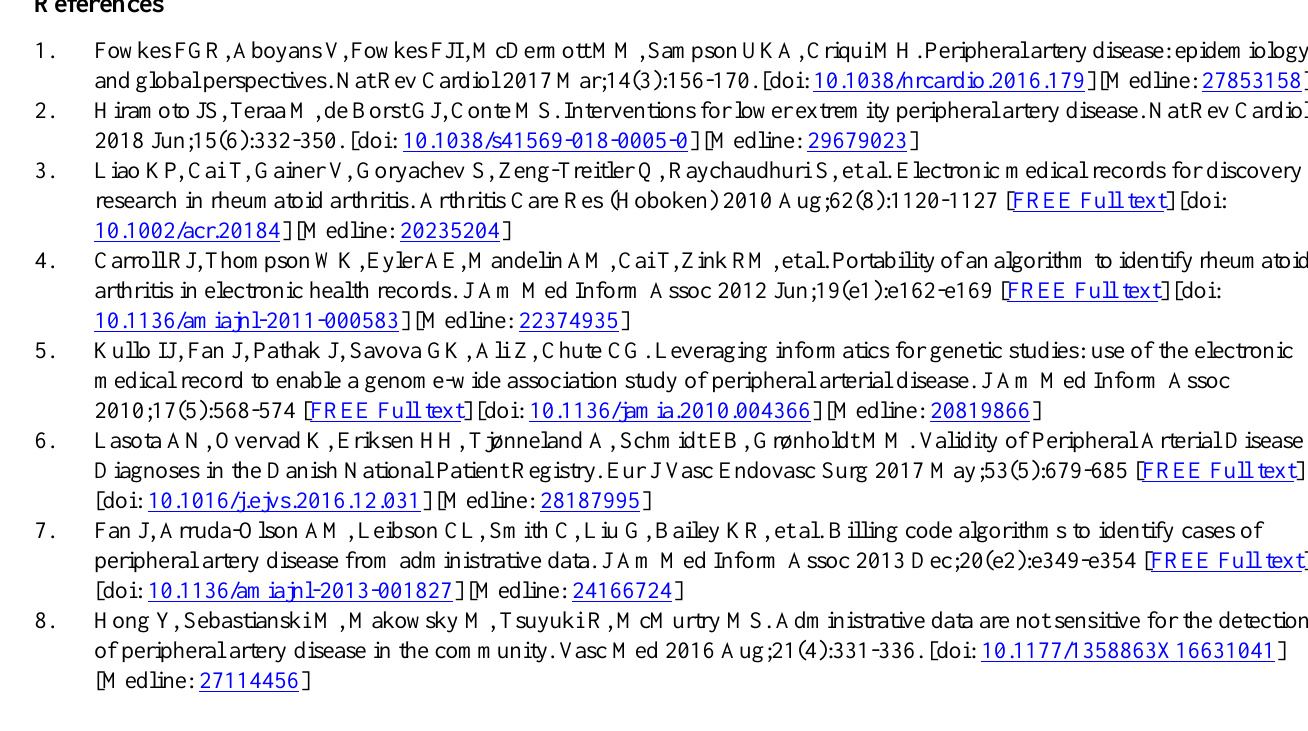
Table of baseline demographics by training versus validation